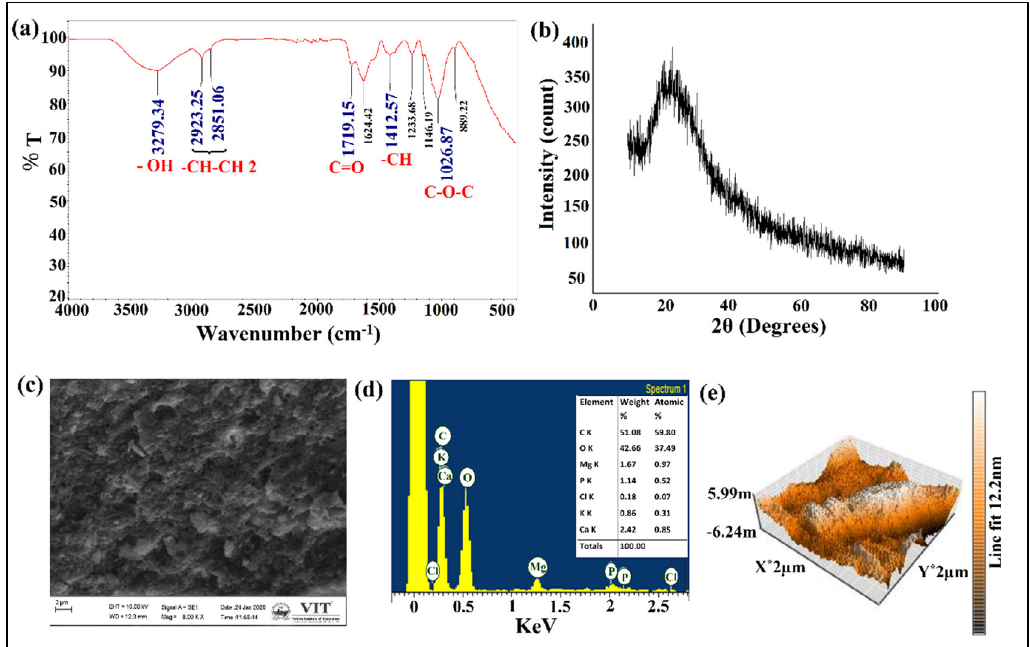
Fig. 1. Characterization of purified Okra bioflocculant using (a) Fourier-transform infrared spectroscopy (FTIR), (b) X-ray diffraction (XRD) analysis, (c) Scanning electron Microscopy (SEM), (d) Energy-dispersive X-ray spectroscopy (EDAX), and (e) Atomic force microscopy (AFM)